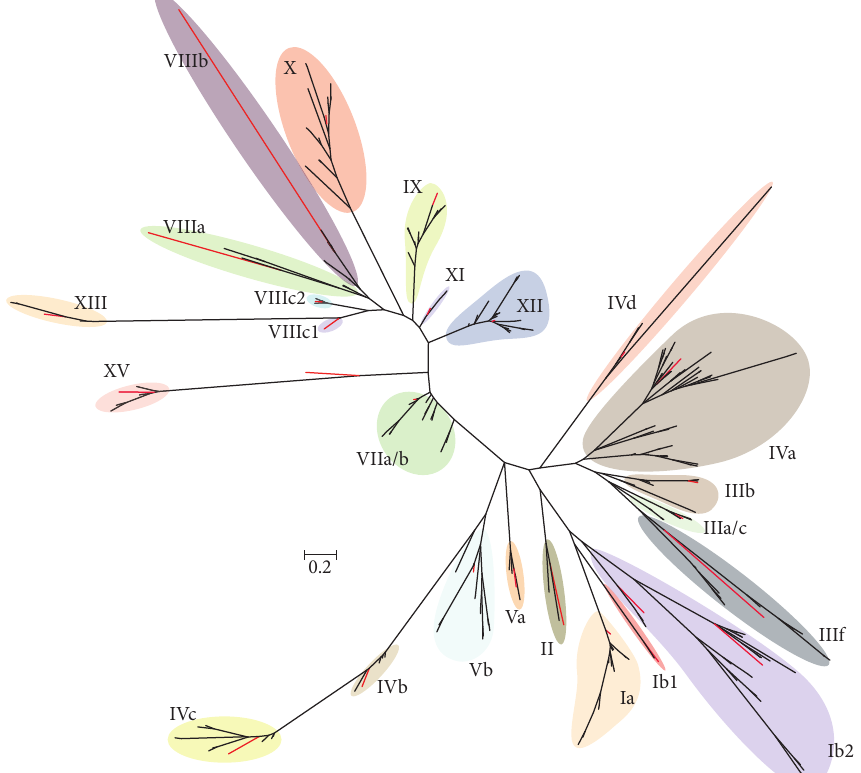
Figure 3: Maximum likelihood phylogenetic tree of soybean bHLH gene families. A radiation diagram is used to represent an unrooted maximum likelihood tree (highest scoring of 1052 bootstraps) with branch lengths proportional to estimated sequence distance. Colored balloons represent named bHLH families identified by sequence similarity to the families in Arabidopsis , and red branches represent Arabidopsis bHLHs included to identify the families. Scale bar represents 0.2 expected amino acid residue substitutions per site. A full version of this tree with individual bHLH sequence names and bootstrap support values can be found in Additional File 4. kingdom that were previously published [1]. The